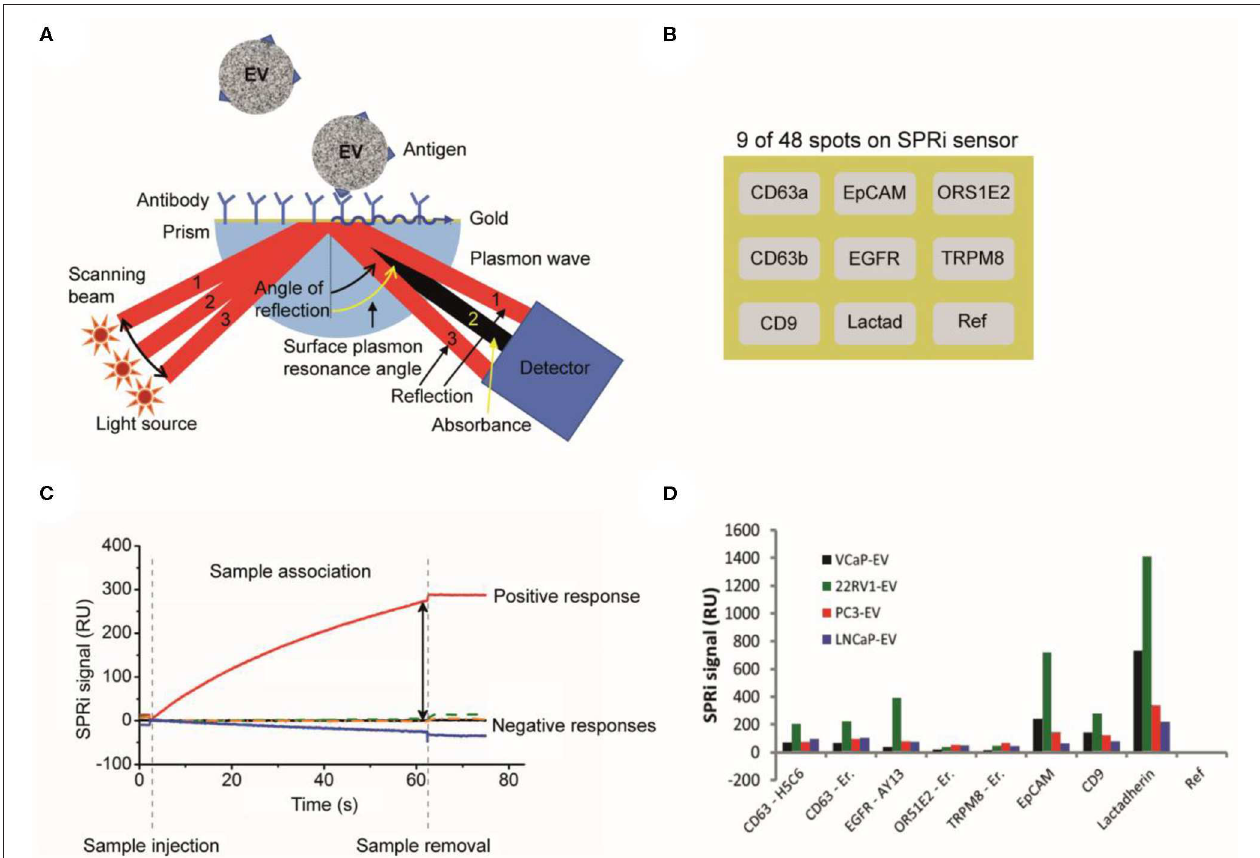
FIGURE 10 | Surface plasmon resonance imaging (SPRi) analysis of extracellular vesicles (EVs). (A) Schematic of a SPRi setup. A SPRi signal is generated when the sensor surface is illuminated at various angles with light and surface plasmons are excited ( 61). The resonance angle, specific angle (beam 2) where maximum plasmon excitation and minimal internal reflection occurs (62), depends on the refractive index contrast near the interface in the evanescent field. (B) The 48 spots on the SPRi sensor surface can be coated with different antibodies. In this example, only nine antibody-coated spots on the SPRi sensor surface are shown. (C) An EV sample is exposed to the SPRi sensor and measured for 60min. The attachment of an ensemble of EVs to a specific antibody spot causes a change in the refractive index and generates a SPRi signal over time (16). (D) The SPRi signals after incubation with four prostate-cancer-derived EV samples are shown. The two CD63 clones show the same results for all samples. All samples are slightly positive for CD63, EGFR, and CD9. A higher positivity is seen for EpCAM and lactadherin. The SPRi signals for the 22RV1-EV sample are higher compared to the other samples (16).